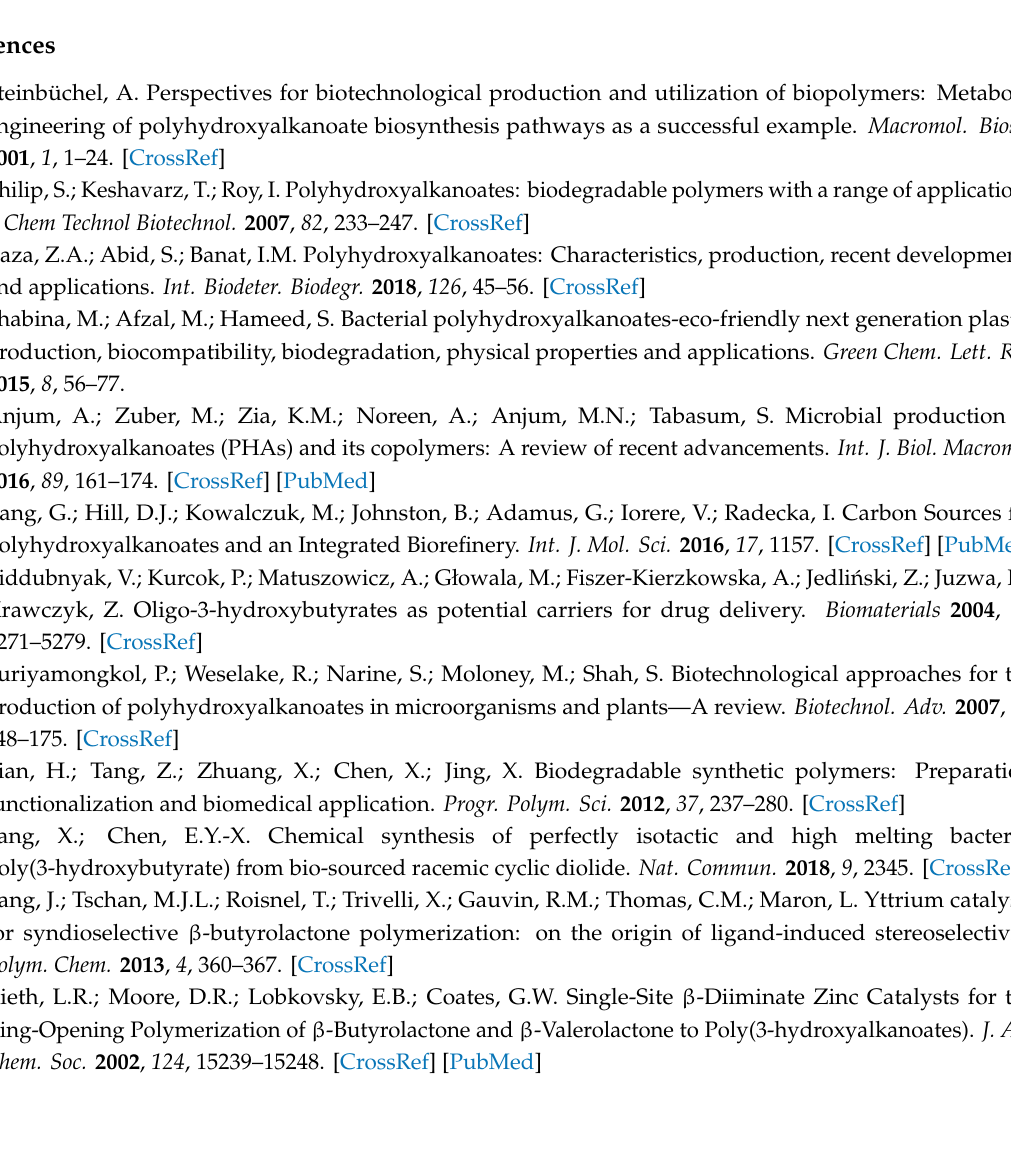
s1, Figure S1: GC-MS spectrum of filtrate obtained via AROP of BL initiated with sodium phenoxide after polymer